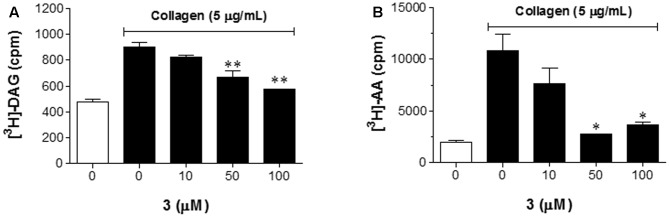
3 suppresses the production of DAG and the liberation of AA. DAG (A) and AA (B) liberation assays were performed using [3H]-AA-labeled platelets. After platelet suspensions were incubated with 3 (10, 50, and 100 μM) or with a PLC inhibitor CaCl2 (1 mM) in the presence of 100 μM indomethacin, the platelets were stimulated with 5 μg/mL collagen for 2 min. The data shown in bar graphs expressed as the means ± SEM are an average of three similar and independent experiments. ∗p < 0.05, ∗∗p < 0.01 vs. control (collagen treatment, but no 3).